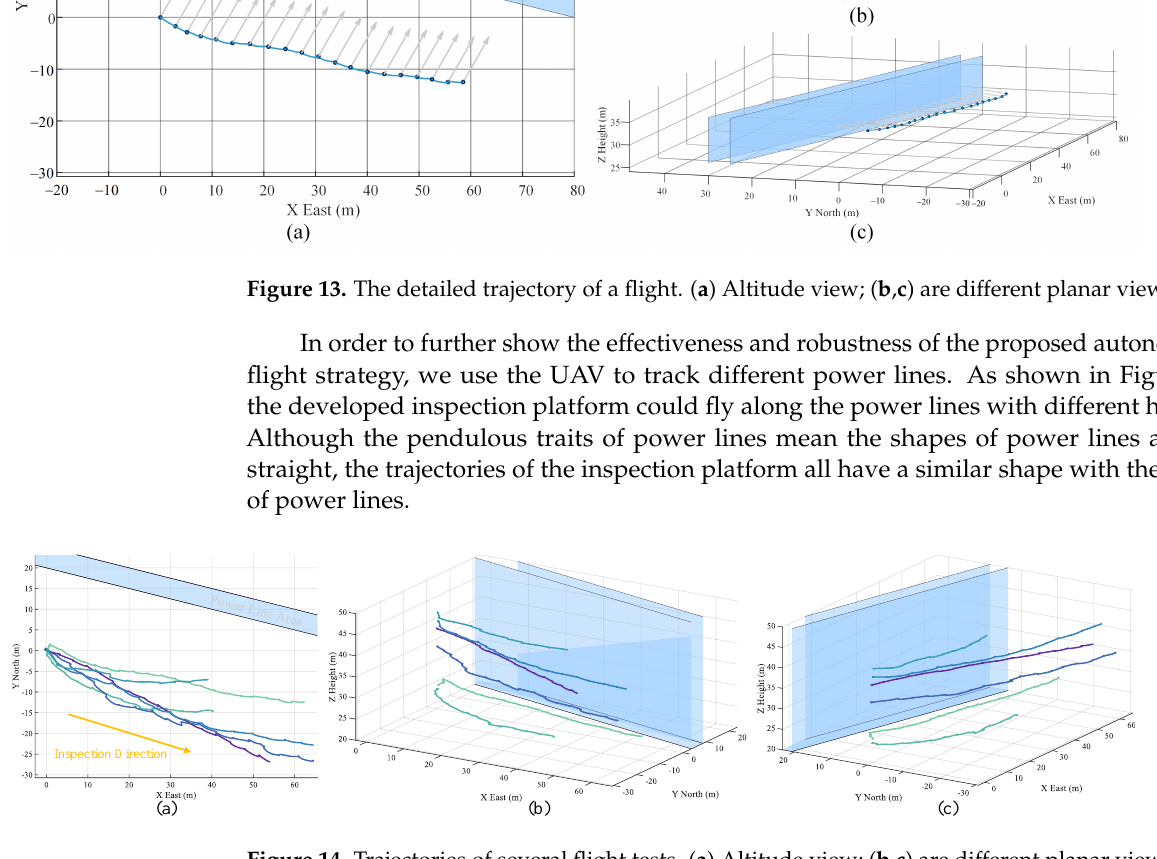
Figure 14. Trajectories of several flight tests. ( a ) Altitude view; ( b , c ) are different planar views.